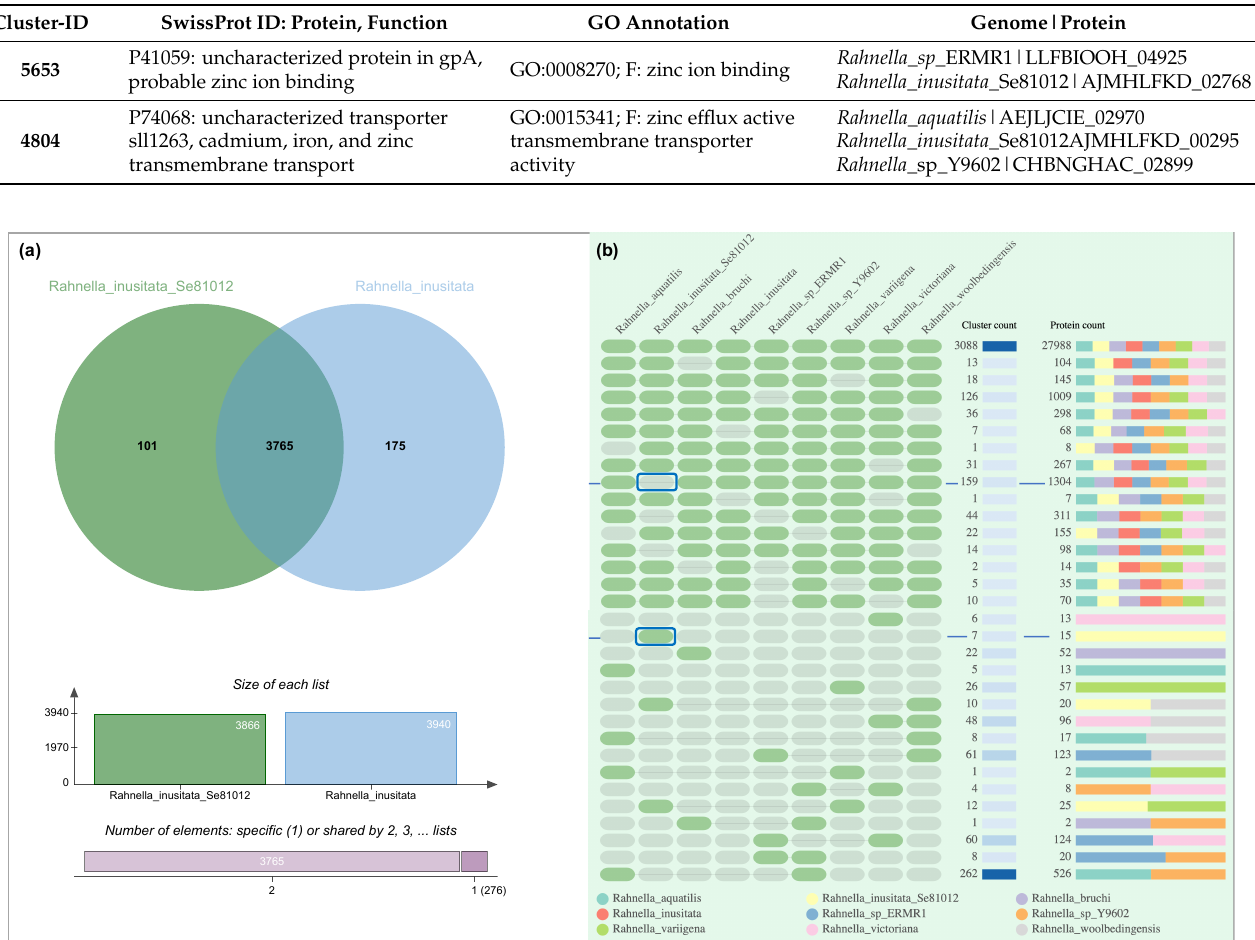
Figure 6. Comparative analysis of orthologous gene cluster across Rahnella species genomes. ( a ) Venn diagram summarizing the distribution of shared orthologous clusters between two Rahnella inusitata genomes, including the Antarctic isolated strain Se8.10.12. ( b ) The occurrence table of main orthologous clusters between Rahnella species showing the 16 first cluster count in descending and ascending order. The presence or absence of a cluster group in the related species is represented by green or gray cells, respectively. The absent and unique clusters on the Antarctic strain Se8.10.12 are marked inside blue